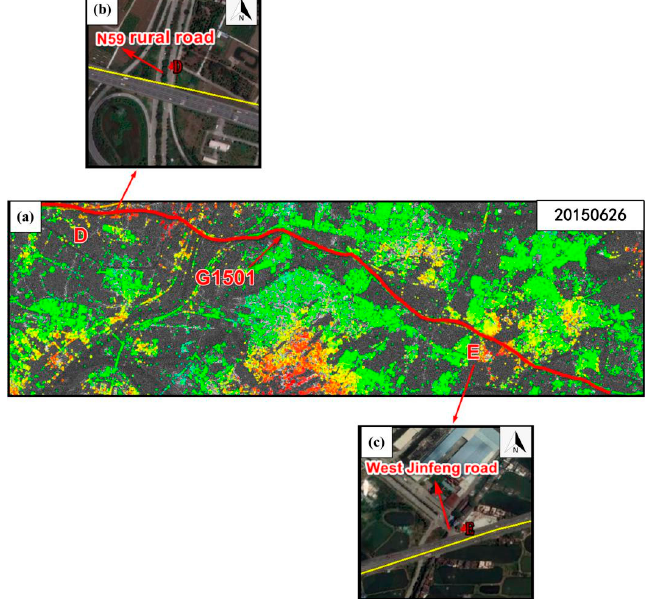
Figure 16. Locations of feature points D and E. ( a ) Deformation map obtained by linear model 27 October 2014, Table 2015, over G1501 Highway. ( b ) Location of Point D in Google Maps; ( c ) Location of Point E in Google Maps.